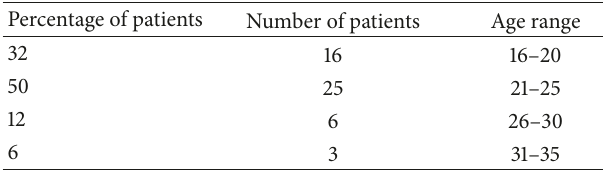
Table 1: The age range of patients poisoned with tramadol referred to Imam Reza (AS) Hospital in